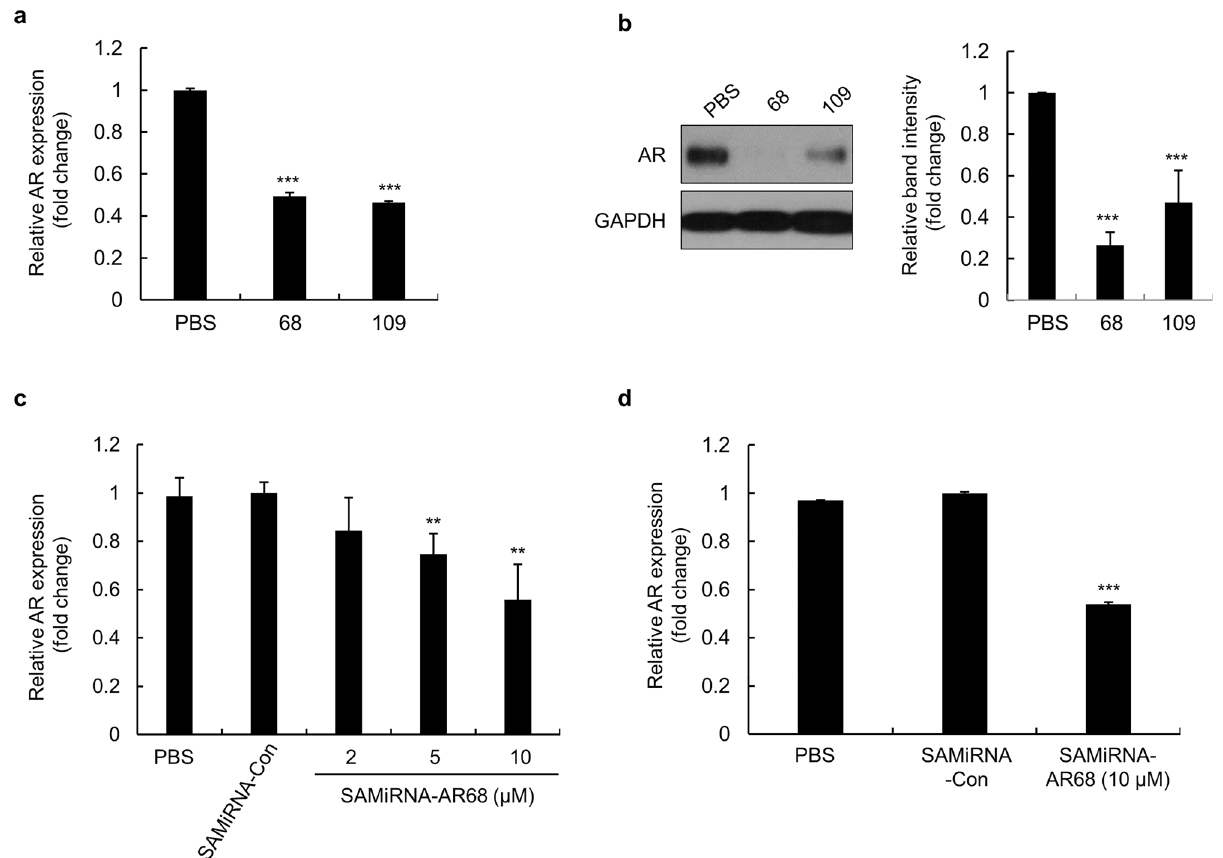
Figure 2. The efficacy of SAMiRNA-AR68 in reducing AR expression in HFDP cells. ( a , b ) Human follicle dermal papilla (HFPD) cells were treated with PBS, SAMiRNA-AR68, or SAMiRNA-AR109 for 48 h. Total RNA extracts were subjected to RT-qPCR assays, and AR expression was normalized to that of the RPLP0 gene ( a ). Whole-cell lysates were subjected to immunoblot analysis ( b , left panel). The intensity of the AR and GAPDH bands was quantified by ImageJ software, and AR protein expression was normalized to GAPDH values ( b , right panel). ( c ) HFDP cells were treated with PBS, SAMiRNA control, or the indicated doses of SAMiRNA-AR68 for 48 h. Total RNA extracts were subjected to qPCR assays, and AR expression was normalized to that of the RPLP0 gene. ( d ) HFDP cells were treated with PBS, SAMiRNA control, or 10 μM SAMiRNA-AR68 for 48 h. Whole-cell lysates were subjected to enzyme-linked immunosorbent assays (ELISAs) to measure AR protein. Statistical significance was assessed by two-sided Student’s t test, ** p < 0.01; *** p <